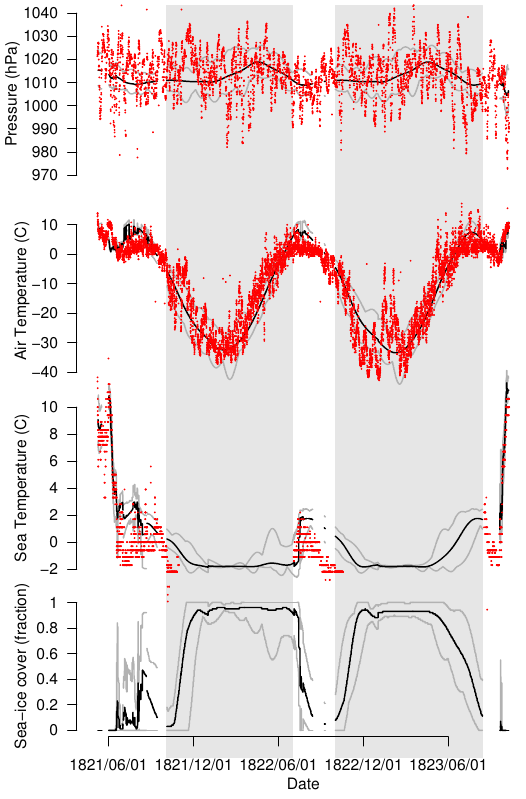
Fig.7. WeatherobservationsfromHMS Hecla in1821–3,comparedwithmodernvalues. Theredpointsaretheexpedition’sobservations, theblackandgreylinesarethemean,maxandminvaluesfrommoderndatasets(monthlyaveragesinterpolatedtodaily,1979-2004;SST Fig. 7. Weather observations from HMS Hecla in 1821–1823, com- andsea-icefromRayneretal.(2003),ATfromRigoretal.(2000),andpressurefromAllanandAnsell(2006)). Thegreybandsmarkthe periodstheexpeditionspentinwinterharbours. pared with modern values. The red points are the expedition’s ob- servations, the black and grey lines are the mean, max and min val- ues from modern datasets (monthly averages interpolated to daily, 1979–2004; SST and sea-ice from Rayner et al., 2003, AT from Rigor et al., 2000, and pressure from Allan and Ansell, 2006). The grey bands mark the periods the expedition spent in winter harbours.